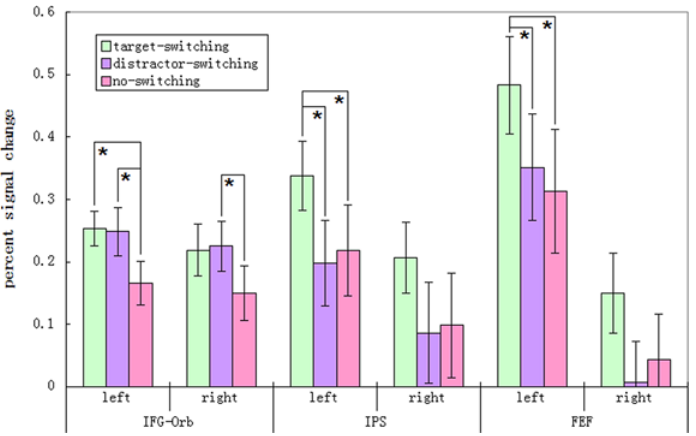
Fig 7. Percent Signal Change in the left IFG-Orb, right IFG-Orb, left IPS, right IPS, left FEF, and right FEF. Means ± SEM (standard errors of the mean) are shown. Asterisks represent significant differences between conditions (Bonferroni